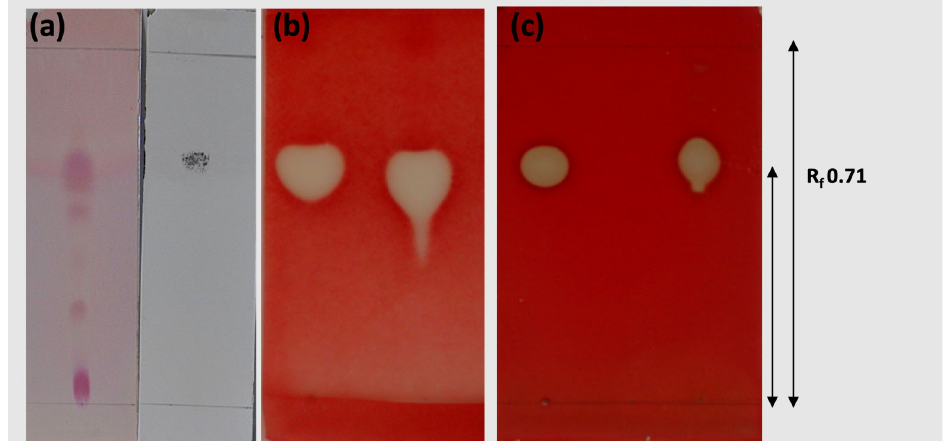
Figure 3. Retention factor in thin layer chromatography (TLC) analysis of the crude lipopeptide extract CL 84 . ( a ) revealed with ninhydrin and cupric sulfate. ( b ) Bioautography against C. gloeospor- ioides growth in an agar overlay and dyed with an aqueous solution of 2,3,5 triphenyltetrazolium chloride and ( c ) in blood agar overlay.